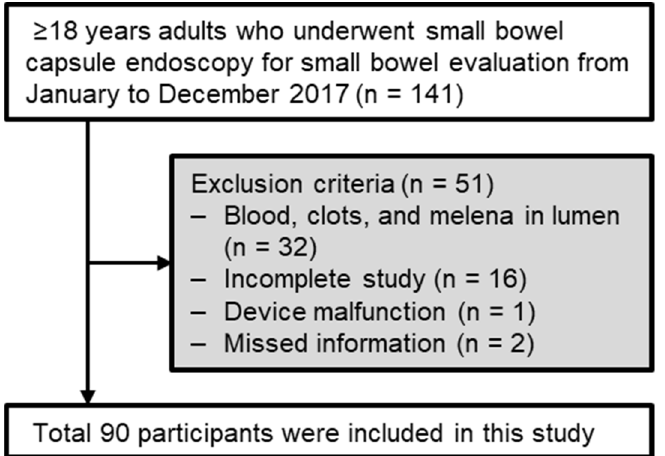
Figure 1. Flow diagram showing the selection of study subjects.